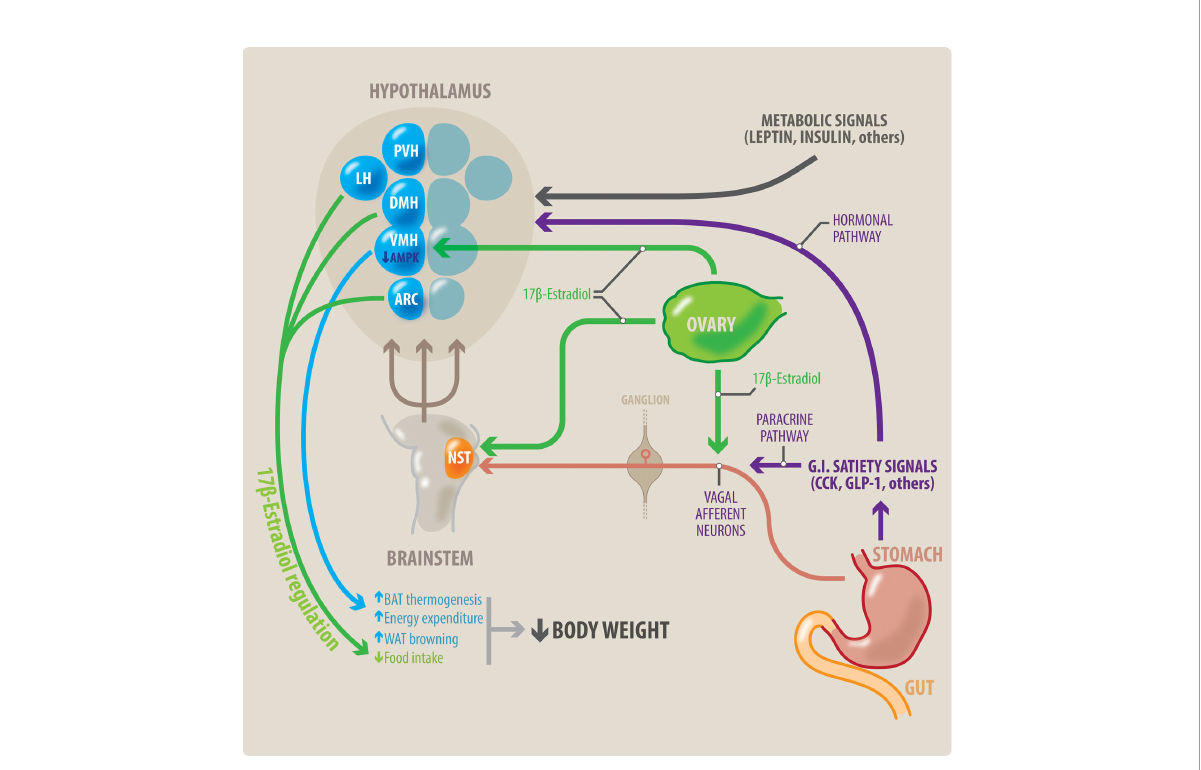
FIGURE 1 Potential interaction between meal-related gastrointestinal signals and estradiol on control of the body weight in women. Meal-related gastrointestinal signals (CCK, GLP-1, others) act through a paracrine-neuronal pathway (shown in purple and red). These meal-related gastrointestinal signals act paracrinally upon vagal afferent neurons (VAN). The VANs activate secondary neurons located in the NTS, in the brainstem. The NTS integrates a variety of peripheral signals, and in turn activates tertiary neurons located in different nuclei in the hypothalamus. These hypothalamic nuclei control feeding behavior. Circulating estradiol (shown in green) modulates the responsiveness to these gastrointestinal satiety signals by acting on all levels of this paracrine-neuronal pathway: The VAN, NTS and the hypothalamic nuclei. Gastrointestinal satiety signals also act directly upon the hypothalamic nuclei through a hormonal pathway (shown in purple). Additionally, estradiol (green) has a direct anorexigenic effect at the level of the hypothalamic nuclei (PVH, LH and ARC), thereby reducing food intake. Metabolic signals such as insulin and leptin also in fl uence centers in the hypothalamus to regulate body weight. Brown adipose tissue (BAT) thermogenesis contributes to regulation of body weight by increasing energy expenditure. Estradiol acts all three points of the VMH-SNS-BAT pathway to increase thermogenesis. Within the VMH hypothalamic nucleus, estradiol acts by inhibiting AMPK. Thus, estradiol increases energy expenditure by increasing BAT thermogenesis, and WAT browning. This, in combination with estradiol ’ s effects to decrease food intake, can result in weight loss. NST, nucleus of the solitary tract; DMH, dorsomedial hypothalamus; LH, lateral hypothalamus; PVH, paraventricular hypothalamus; ARC, arcuate nucleus; VMH, ventromedial hypothalamus; BAT, brown adipose tissue; WAT, white adipose